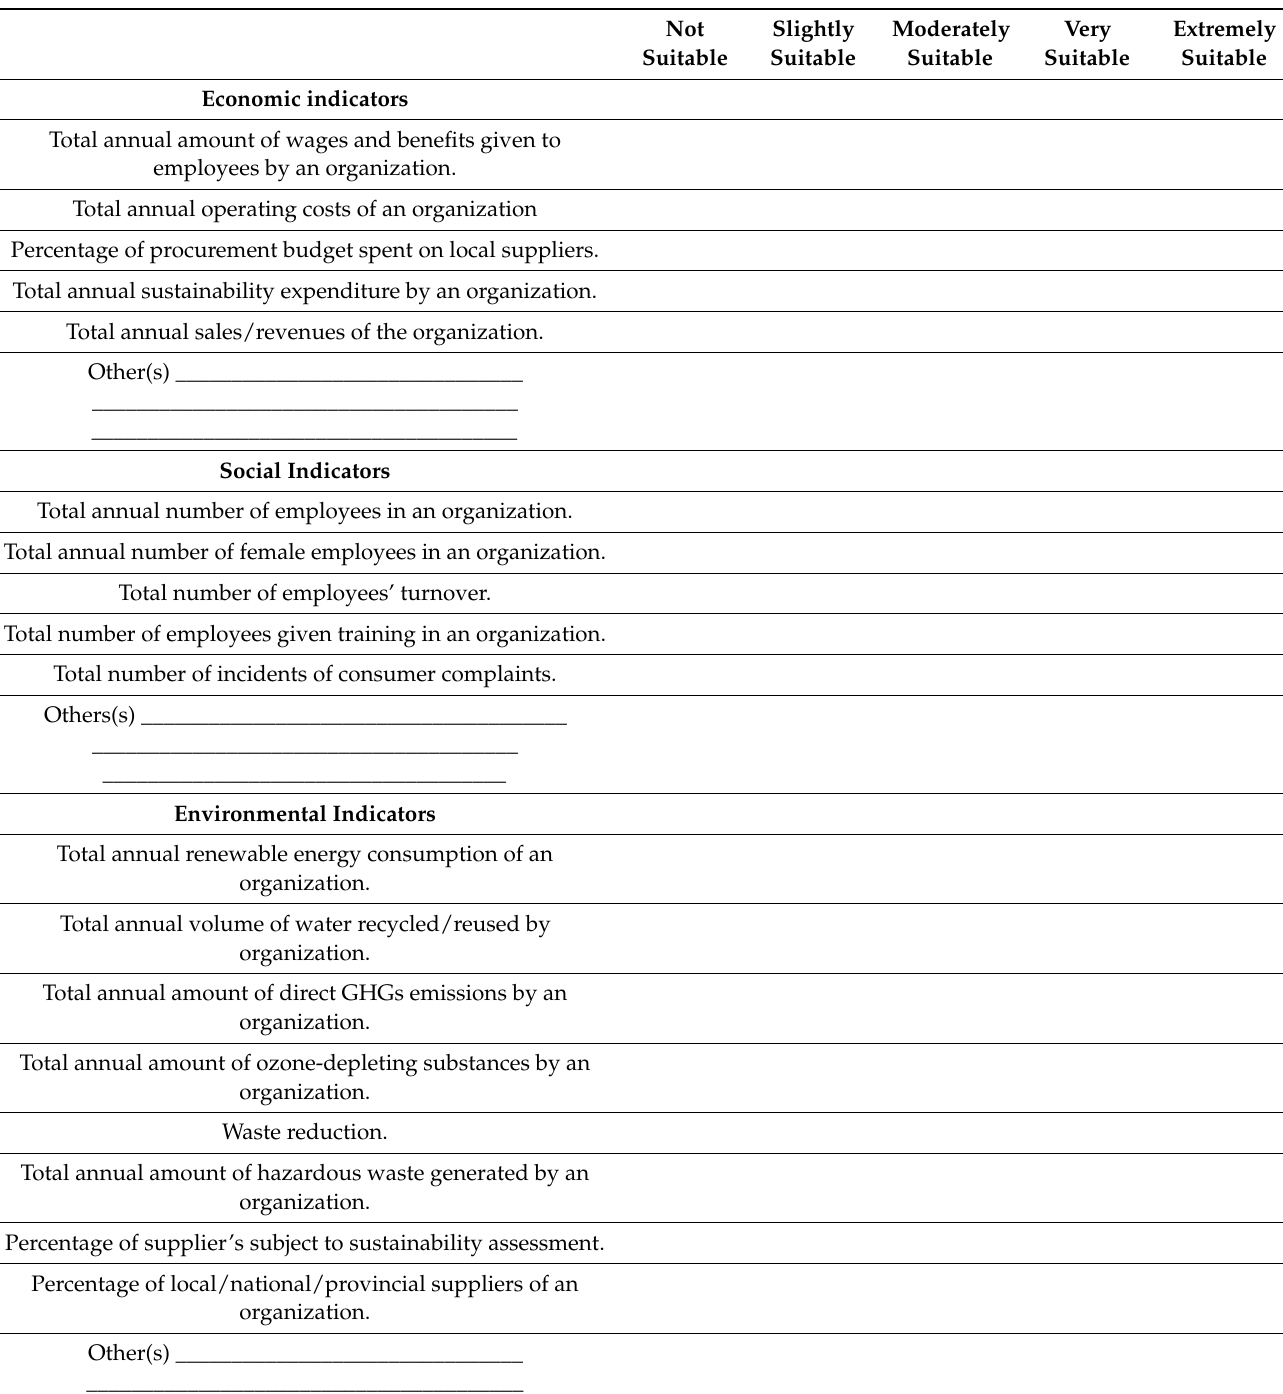
C—Sustainable Performance of a Supply Chain 4.0—KPIs Suitability